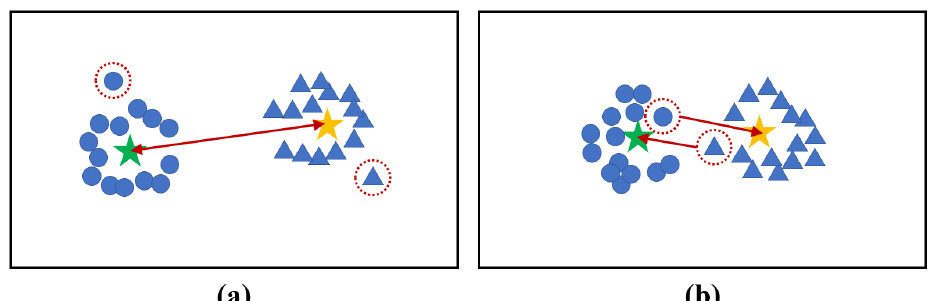
Figure 3. ( a ) The constraint on the centers of RGB modality and IR modality. However, there are some outliers in the learning process. ( b ) The proposed C 3 L constrains the local features and their heterogeneous centers, which alleviates the influence of outliers. The red arrows denote the constraints between features, whereas the dotted circles signify outliers. The stars indicate the centers, and the circle and the triangle represent the RGB modality and IR modality,